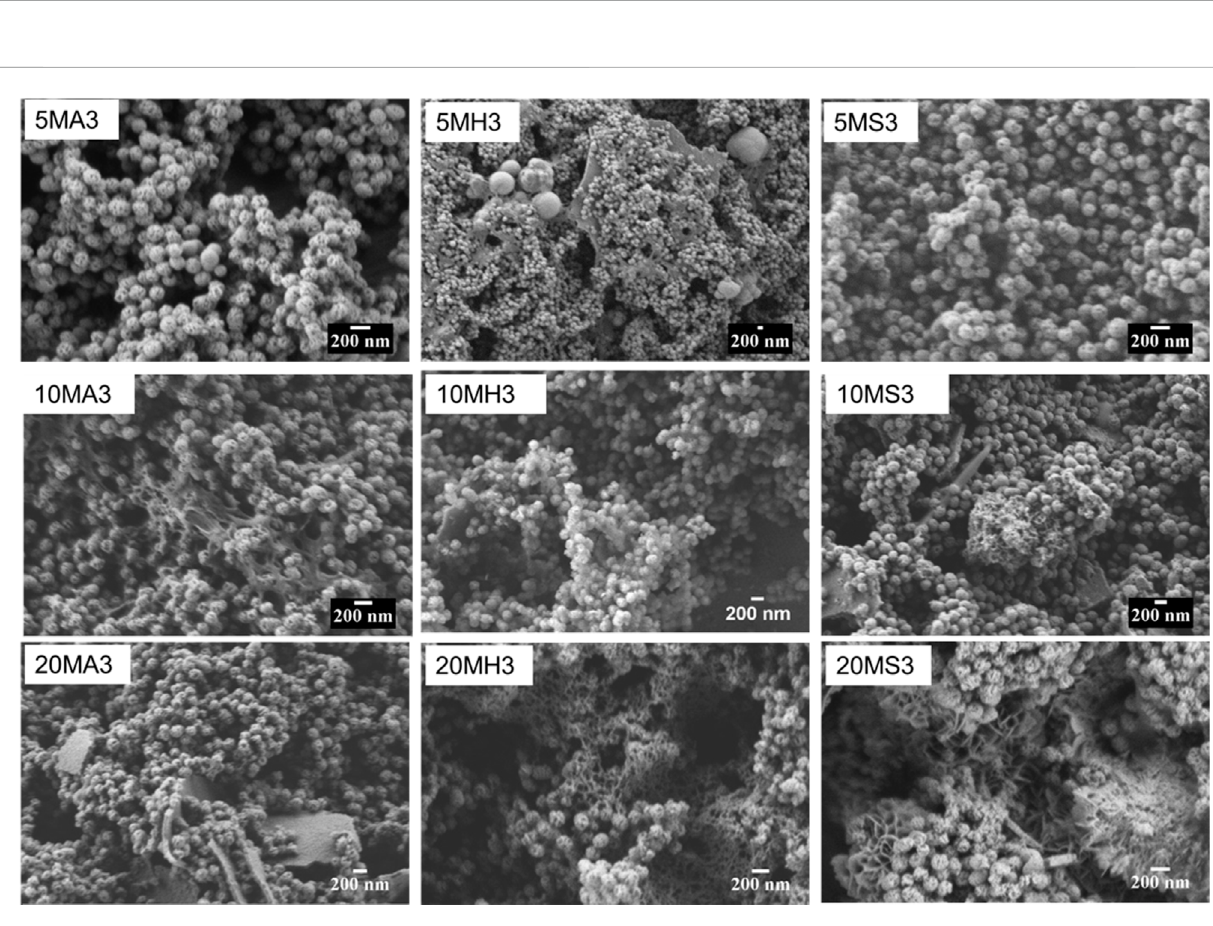
Frontiers in Bioengineering and